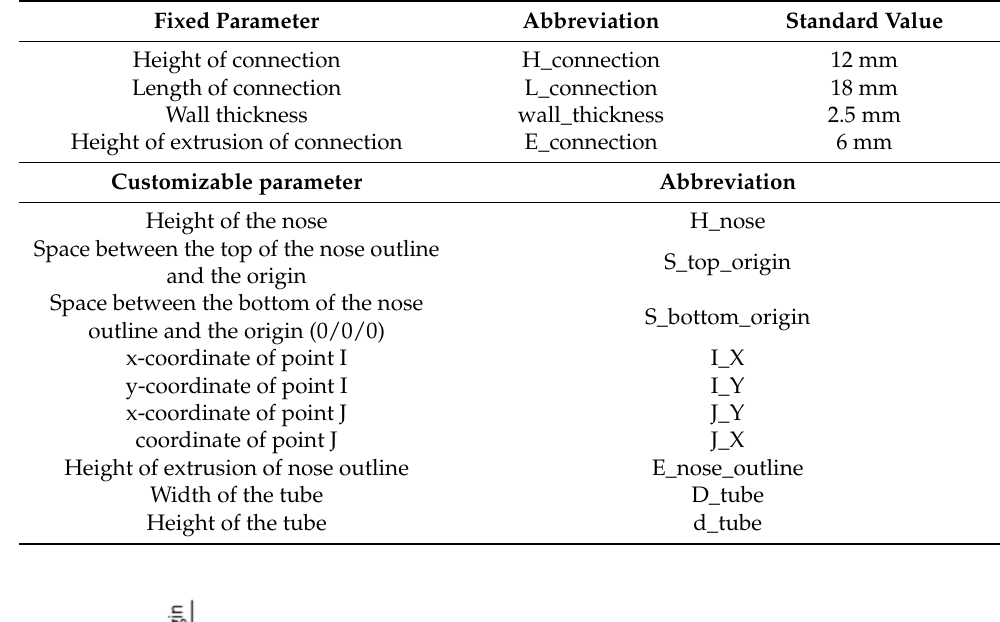
Table 2. Summary of the customizable and fixed parameters for nasal masks.